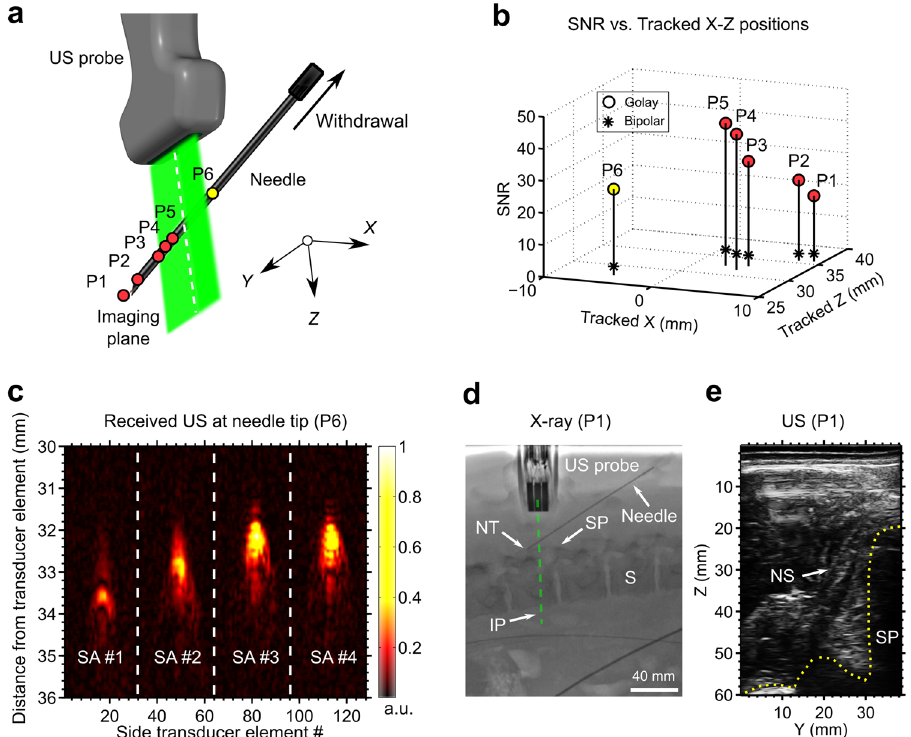
Figure 4. Needle insertion into the spinal region of a swine in vivo with concurrent 3D tracking. ( a ) Tracked positions (circles: P1–P6) obtained during withdrawal of the needle; the circle colour (red/yellow) indicates the side of the ultrasound (US) imaging plane in which the needle tip resided. The imaging plane is depicted in green; the white dashed line indicates intersection between the imaging plane and the lateral position of the needle shaft. ( b ) The signal-to-noise ratio (SNR) of the decoded US signals at the needle tip increased with proximity to the imaging plane. ( c ) In the concatenated decoded signals received from tracking transducer elements of the 4 side-arrays (SA), prominent maxima were observed (expanded vertical scale). These maxima corresponded to transmissions received by the needle tip (signals correspond to tracked position P6). ( d ) Out- of-plane needle tip placement was confirmed with X-ray fluoroscopy (image corresponds to tracked position P1). NT: needle tip; SP: spinous process; S: spine; IP: imaging plane. ( e ) With US images acquired from the central array of transducer elements, the needle shaft was faintly visible. The apparent location of the needle shaft on US imaging was consistent with the tracked positions, extrapolated to a zero out-of-plane distance (image corresponds to tracked position P1). NS: needle shaft; SP: spinous